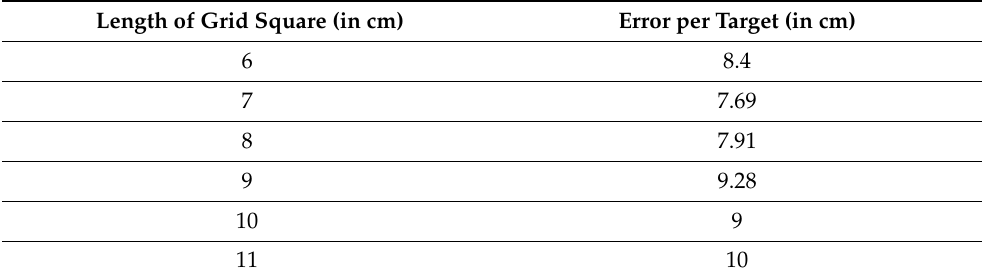
Table 2. Impact of the grid square side’s length on the proposed algorithm. Length of Grid Square (in cm)